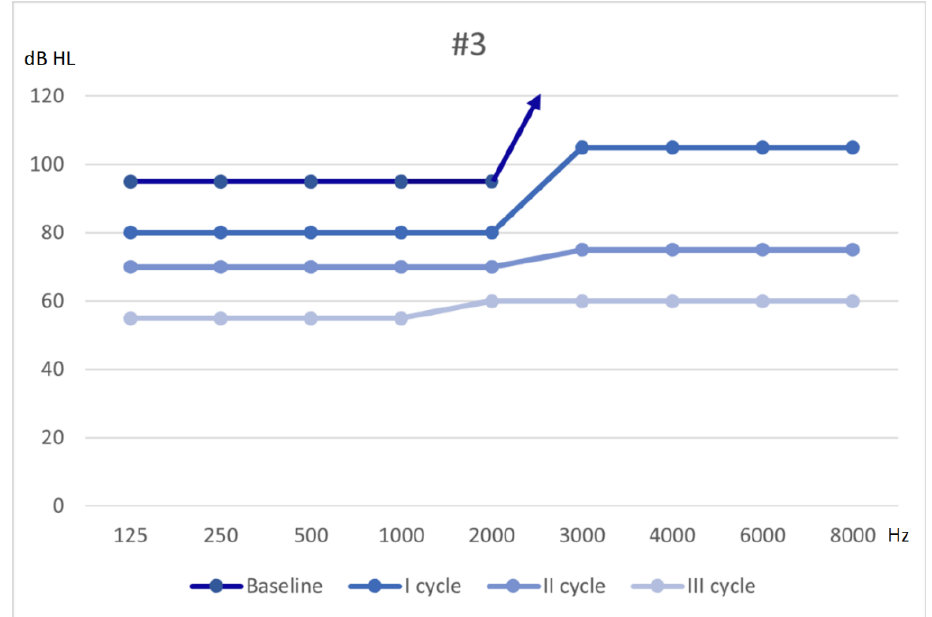
Figure 3. Hearing threshold from baseline to outcome (3 cycles of